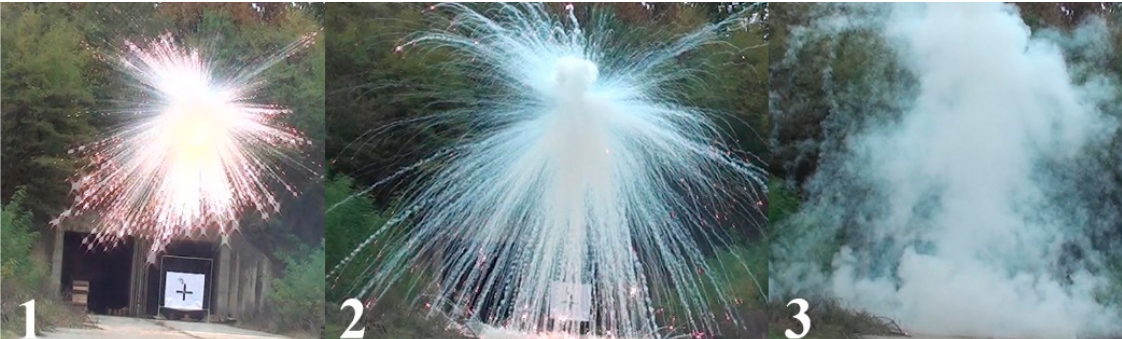
Figure 2. Three-step smoke screen formation: 1—PC1 combustion, instant smoke screen; 2—PC2 and PC3 combustion, smoke screen formation; 3—PC3 continue to supply the smoke